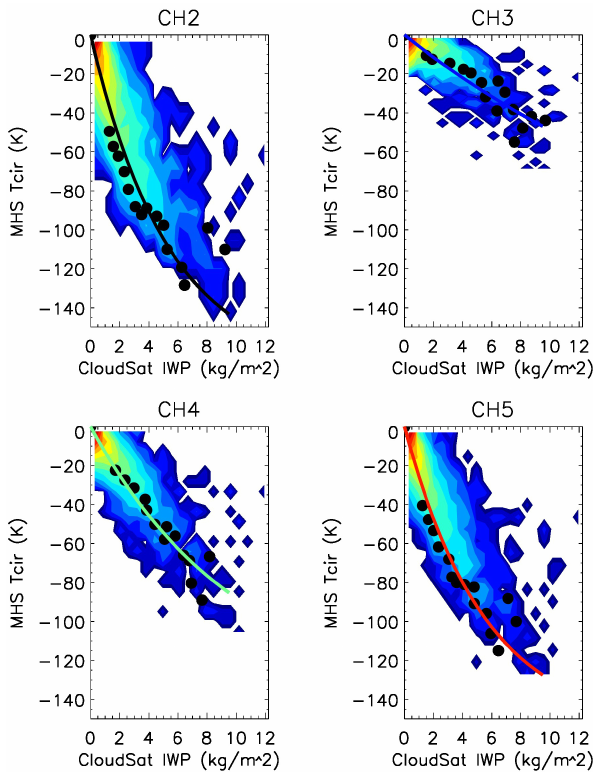
Figure 3. Contours of 2-D PDFs (normalized by the maximum value of the histogram) of collocated CloudSat IWP (abscissa, av- eraged onto MHS footprints) and MHS T cir (ordinate) for CH#2– CH#5 at near-nadir views (scan angle ∈ [− 5 ◦ , 5 ◦ ] ). Black dots lo- cate the peak of the 2-D PDFs, and the thick solid lines are regres- sion curves using Eq. (2).